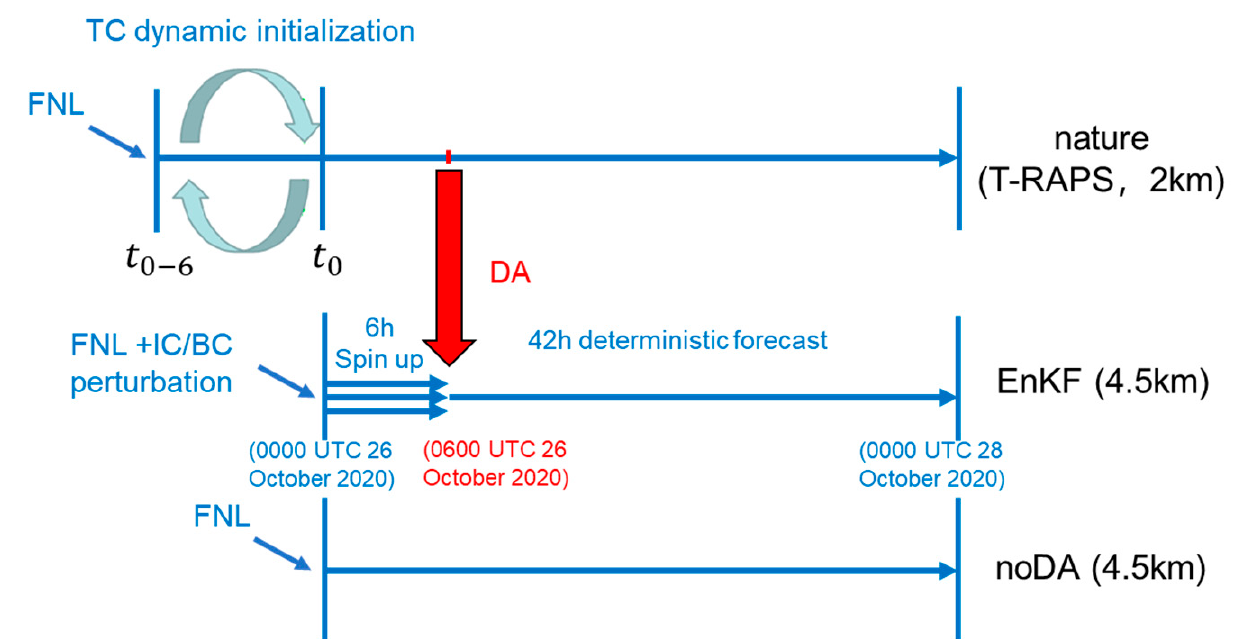
Figure 1. Schematic flowchart for the nature run, EnKF, and noDA experiments. The three blue parallel arrows represent ensemble spin-up before the DA cycles. The red arrows show the assimilation of simulated radar observation at 06:00 UTC on 26 October 2020. The blue arrows present forecasts with the ensemble mean of EnKF or FNL initial condition (noDA experiment).